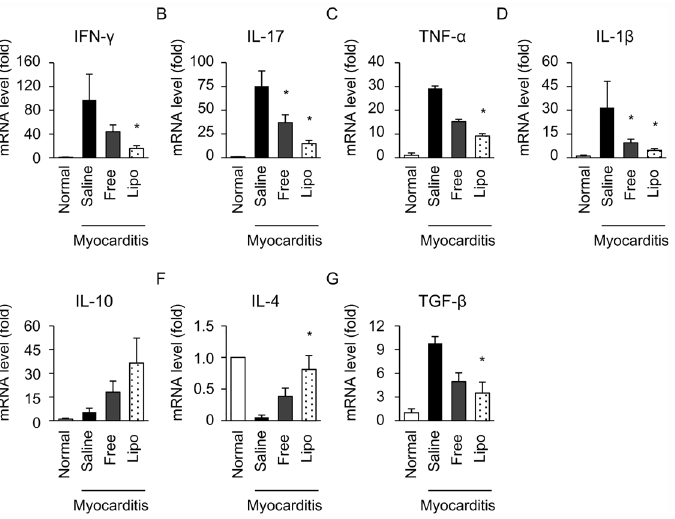
26.96 ± 2.66%, n = 3 vs. saline: 42.39 ± 3.00%, n = 4) and fibrosis (free FK506: 42.28 ± 1.51%, n = 4, liposomal FK506: 38.83 ± 1.58%, n = 3 vs. saline: 51.00 ± 1.39%, n = 4) in the myocarditic